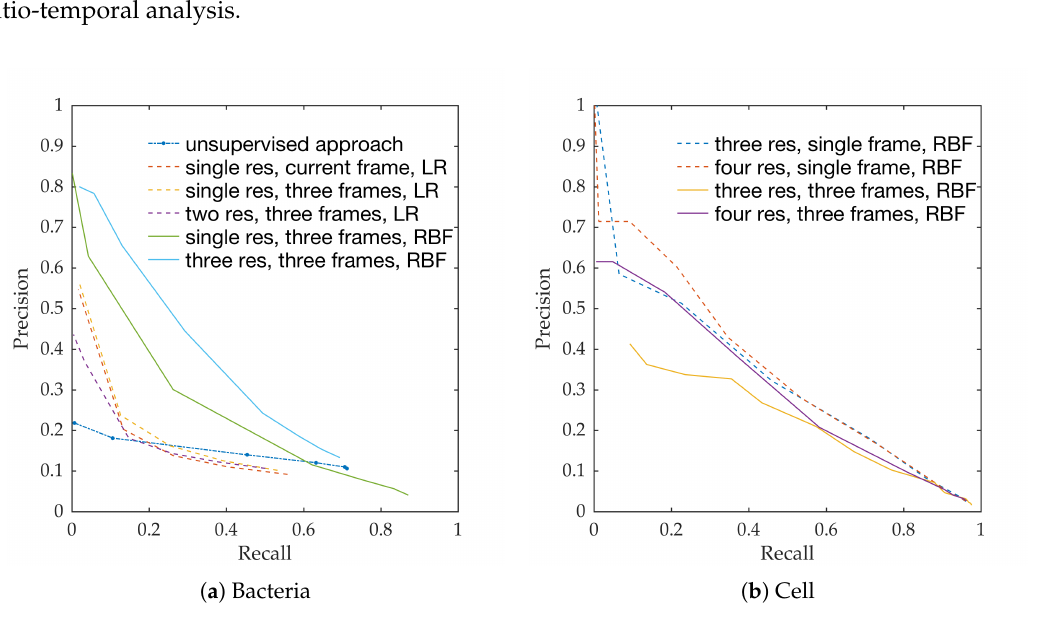
Figure 10. Precision-recall curves for different learning methods (logistic regression (LR) or radial basis function (RBF) network) and different spatio-temporal feature extraction strategies, i.e., different spatial resolutions (res) and different temporal resolutions (frames) in detecting bacteria and cell.